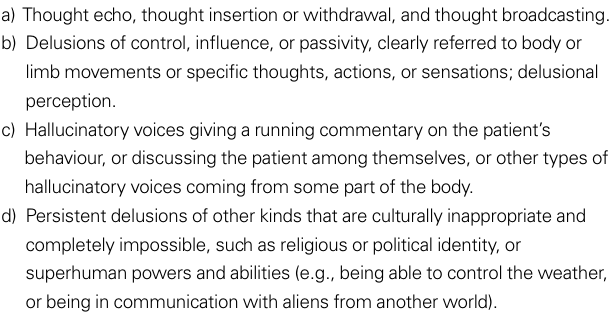
Table 1 | Core symptoms of schizophrenia according to the